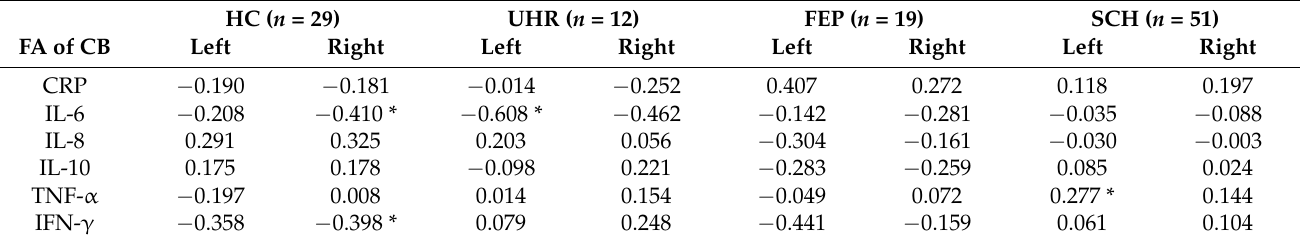
Table 2. Spearman rank correlation coefficients ( ρ ) for inflammatory markers and fractional anisotropy (FA) of the left and right cingulum bundle (CB) in all analyzed